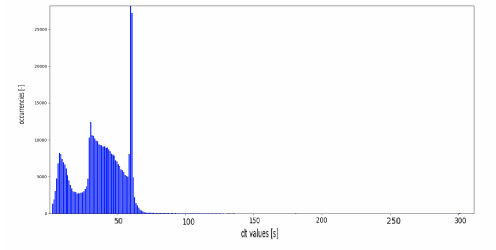
Figure 3. Histogram of ∆ t in the case of line 11 before the outlier